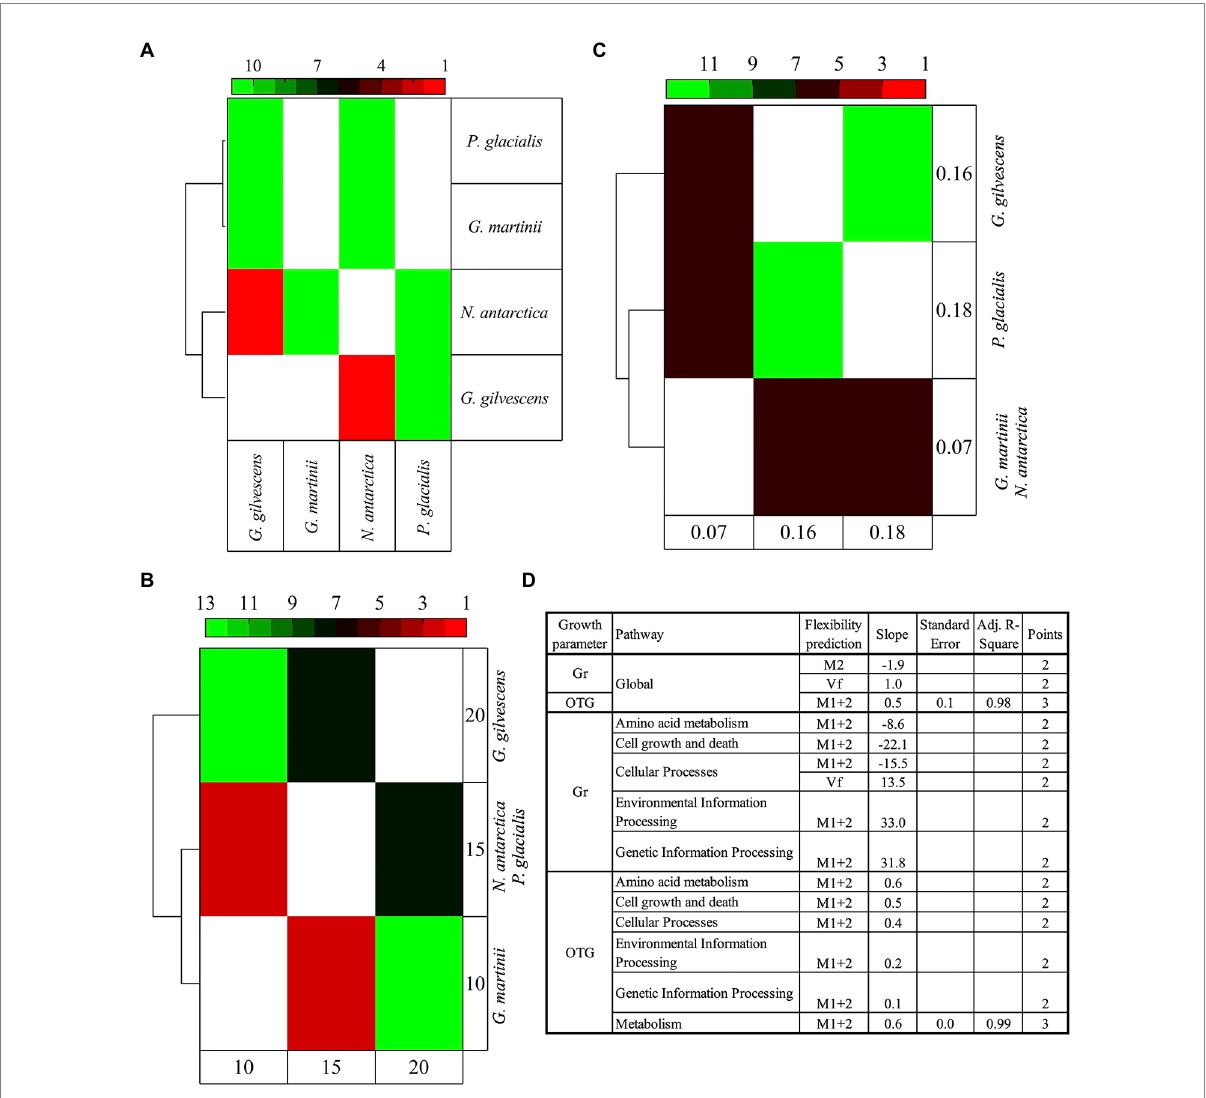
FIGURE 5 Comparative analysis of yeast species according to predicted protein flexibilities and growth parameters. The predicted flexibility of CDSs grouped by cellular functions were compared among species individually (A) and grouped according to their optimal temperature for growth (B) and growth rate (C) . The heatmap shows the number of cellular pathways for which significant difference (Tukey post hoc tests, p < 0.05) were found between yeasts. In (D) the plot of the difference between yeasts for a pathway in flexibility parameters (P1-2) vs. difference in growth parameters (F1-2) is shown. OTG, optimal temperature for growth; Gr, growth rate; Vf, very flexible; M2, class2 flexibility predicted by MEDUSA; M1 + 2, class 1 + class 2 flexibility predicted by